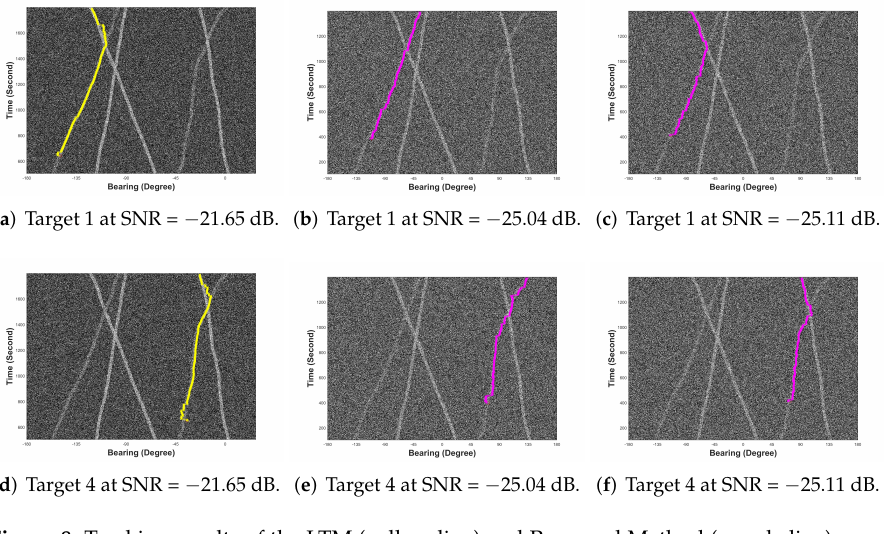
Figure 8. Tracking results of the LTM (yellow line) and Proposed Method (purple line) over different SNRs.